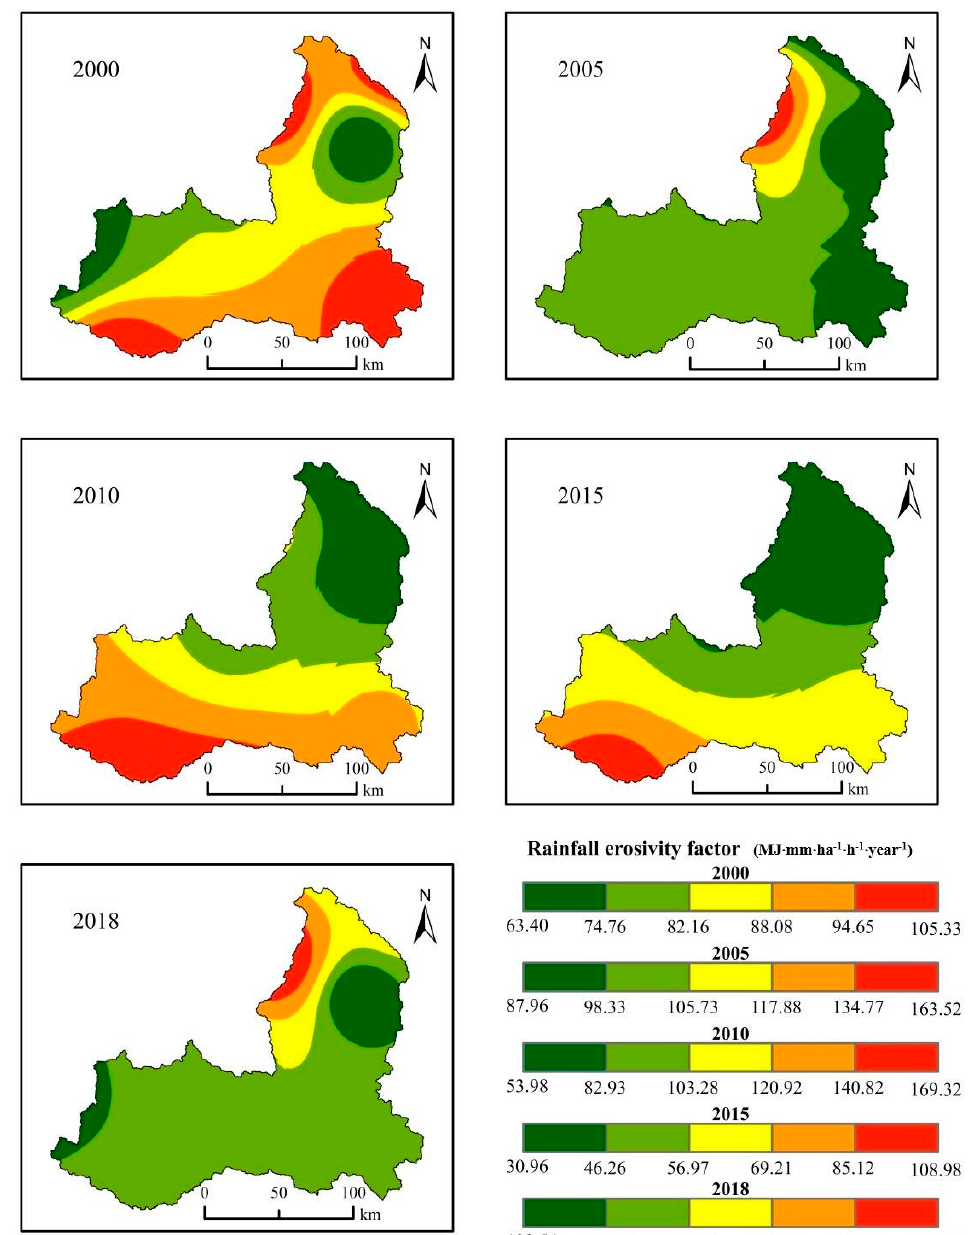
Figure 2. Spatial distribution of rainfall erosivity factor in the Taohe River Basin in 2000, 2005, 2010, 2015 and 2018.